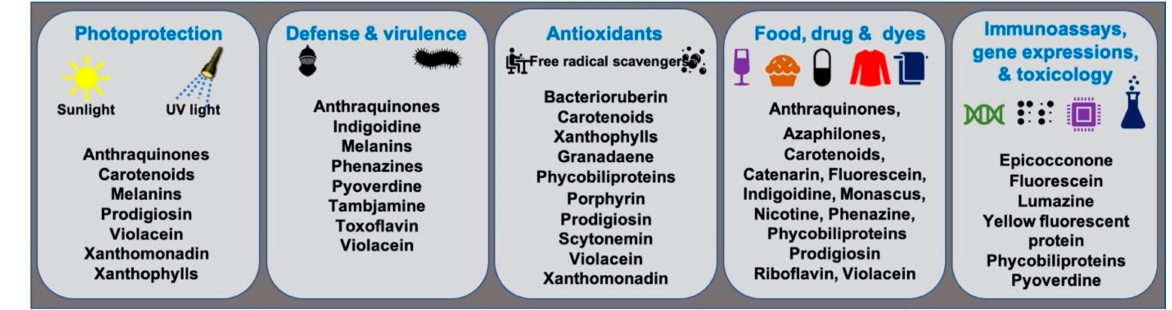
Figure 2. Ecological functions and other applications of important microbial